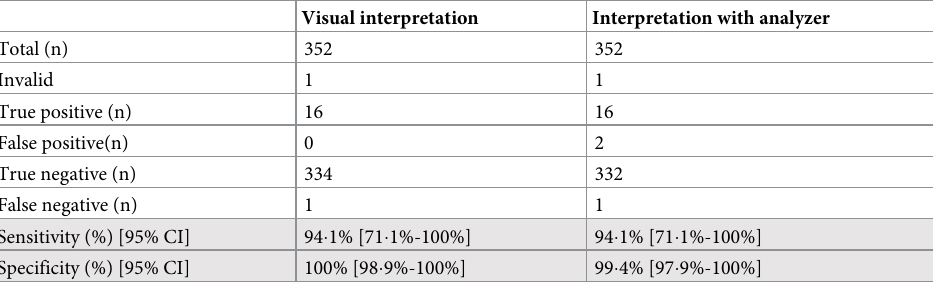
Table 1. VRD performance compared to qRT-PCR in study part one.